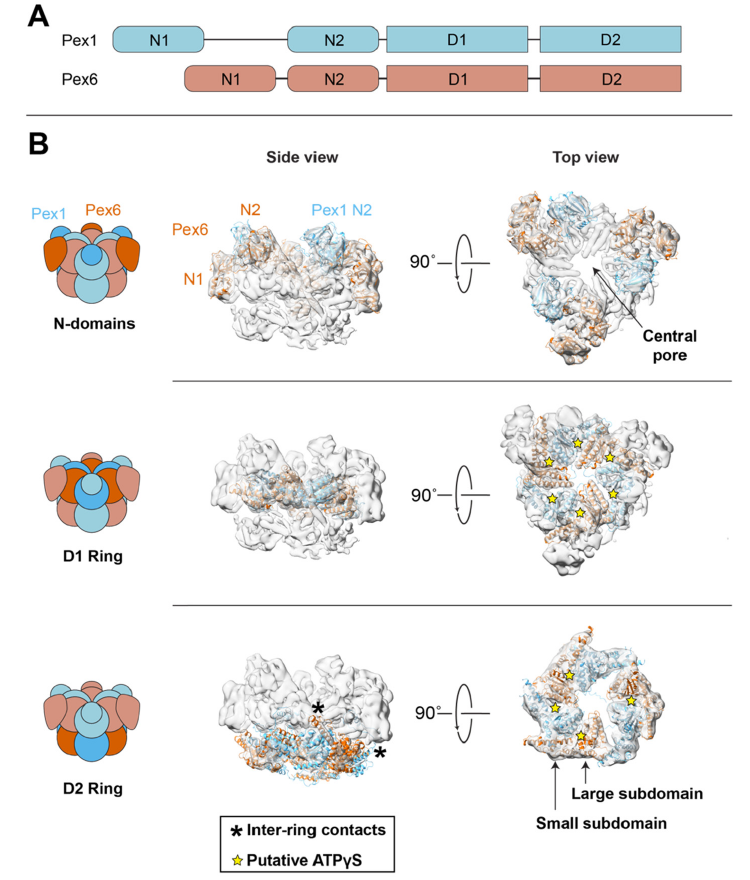
Figure 2. Pex1/Pex6 is a double ring hexameric complex with alternating subunits. ( A ) Pex1 and Pex6 each have two N-terminal domains and two ATPase domains. Pex1 N1 is flexibly attached to the rest of the complex. ( B ) S. cerevisiae Pex1/Pex6 structure, based on AlphaFold2 models (red and blue) split by the domain and fitted into EMDB-6359 (gray) [143]. Map resolution: 7.2 Å; fit correlation coefficient: 0.83. The Pex1 and Pex6 N2 domains bind above the D1 ATPase ring, while the Pex6 N1 domain binds to the side of the D1 ATPase ring. The Pex1 N1 domain was not resolved. The D1 ATPase ring binds but does not hydrolyze ATP and is thought to contribute to hexamer assembly. The top view of the active D2 ATPase ring is displayed at a lower threshold than other maps. Asterisks show sites of contact between D1 and D2 rings (see text). Stars represent expected ATP-binding sites based on inter-protomer distances